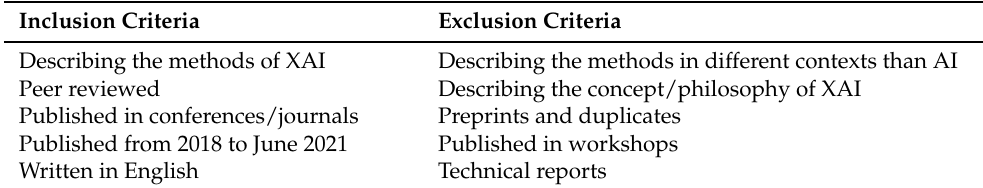
Table 1. Inclusion and exclusion criteria for the selection of research